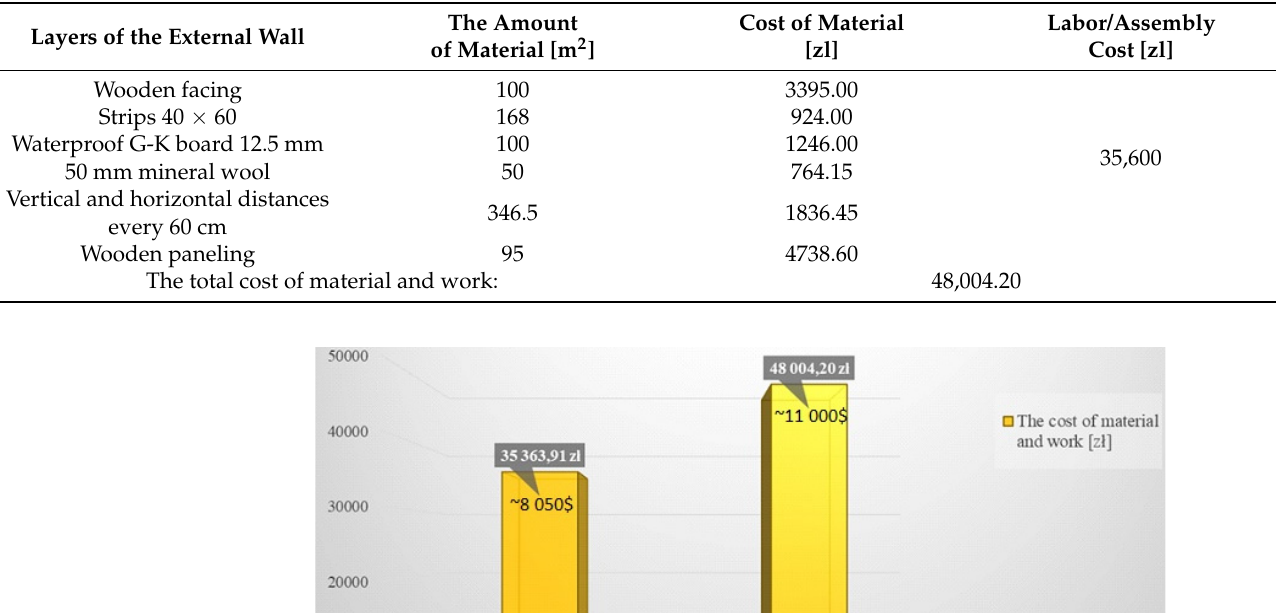
Table 3. The cost of finishing external walls using Scandinavian technology presented in Polish currency (zloty, PLN).